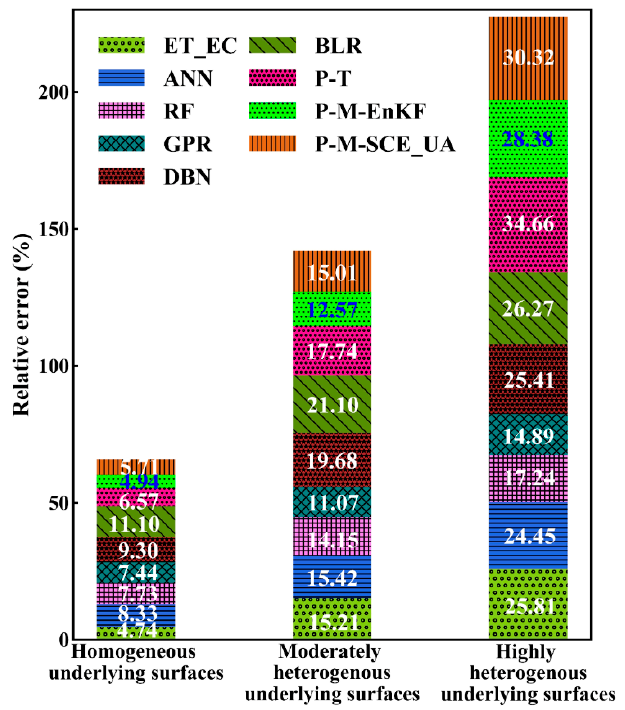
Figure 8. Intercomparison of eight upscaling methods and ET_EC based on the TCH